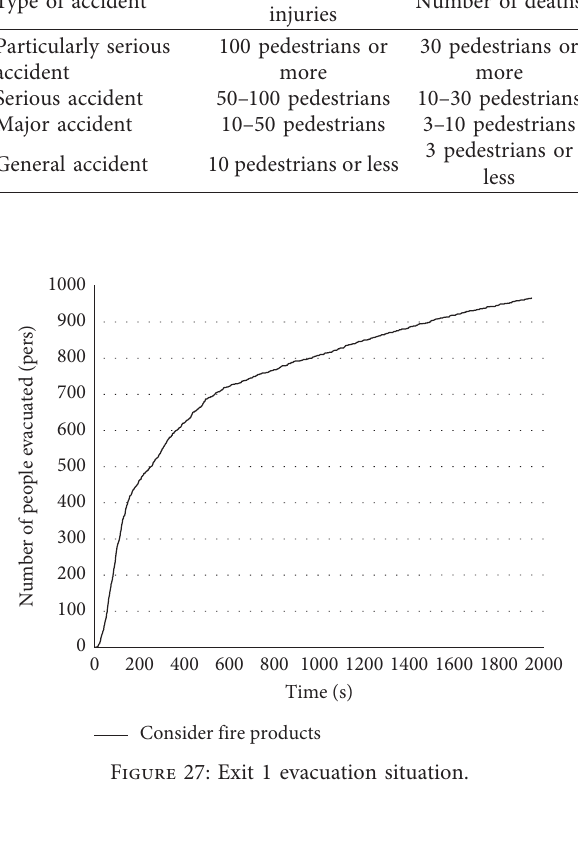
Figure 28: Exit 2 evacuation situation.